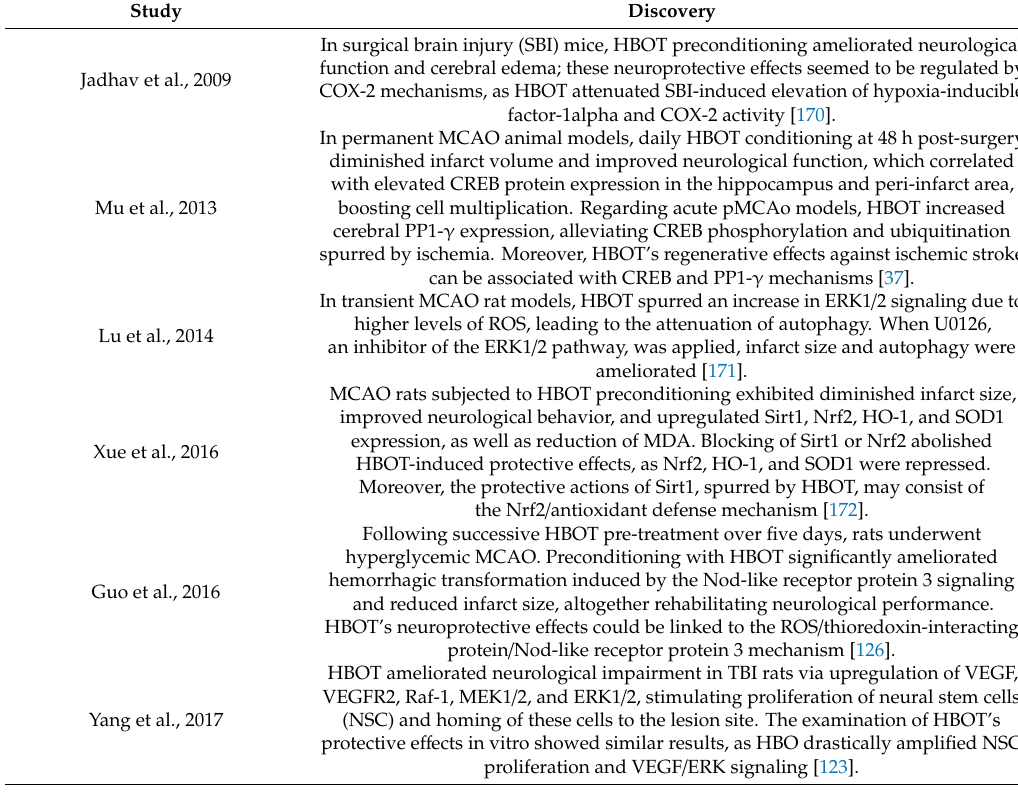
Table 1. Chronological Reports of the Mechanisms Regulating HBOT-Induced